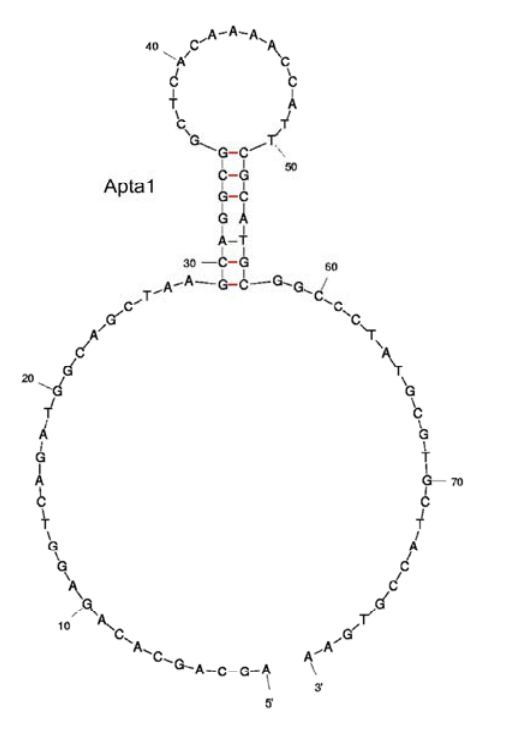
Figure 3. Secondary structure prediction of Apta1. The structure was determined using the mfold